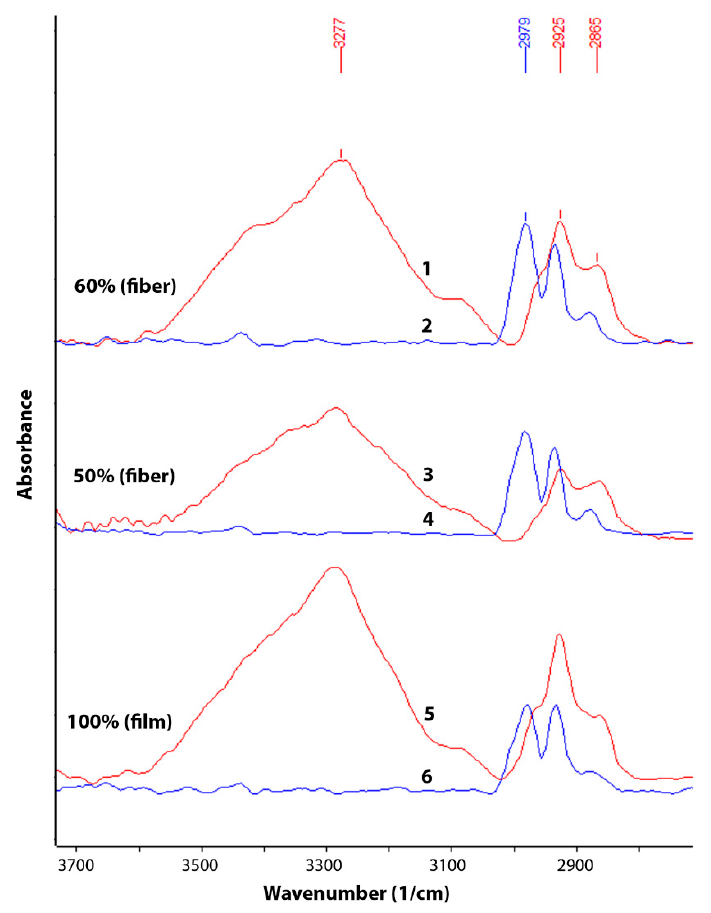
Figure 3. IR spectra (ATR method) in the wavelength range of 2700–3700 cm − 1 of the initial samples (2,4,6) and samples after 60 days of testing by the Sturm method (1,3,5): PHB/CHT (fibers)—(60/40) (1 and 2), PHB/CHT (film)—(50/50) (3 and 4), PHB (film) (5 and 6).